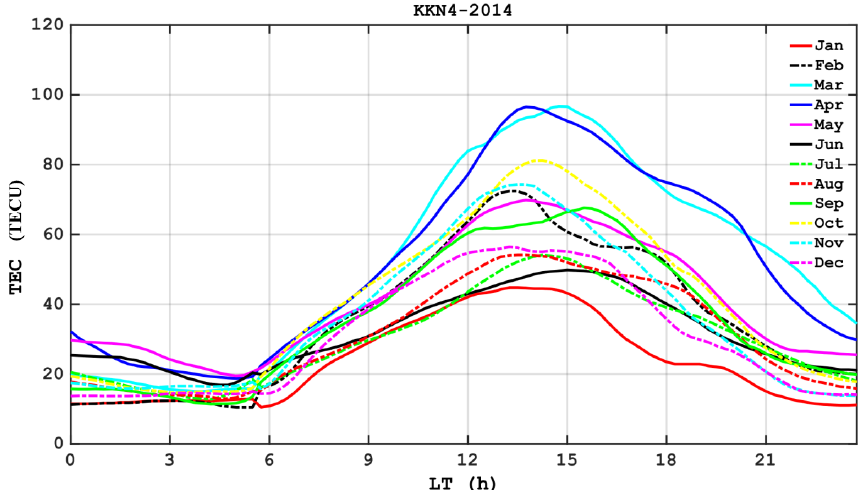
Figure 4. Monthly variation in vertical TEC in LT for each month of 2014 at KKN4